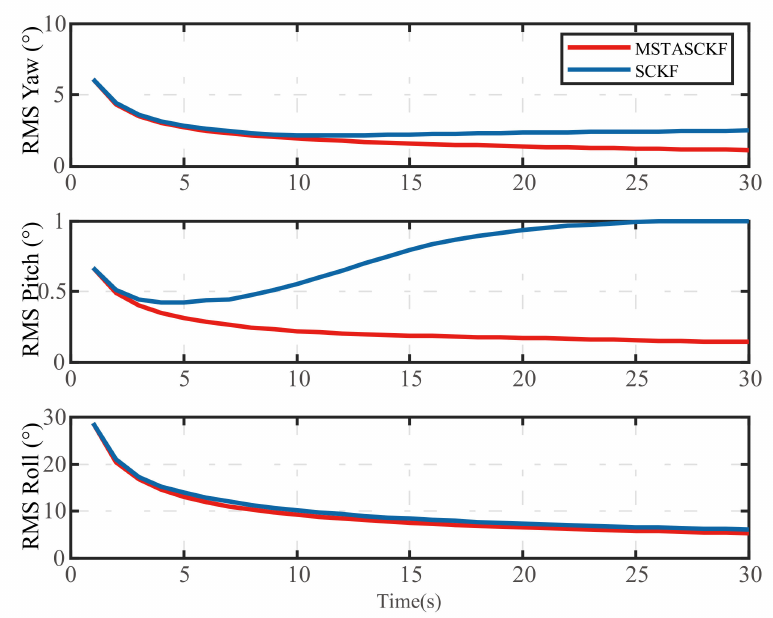
Figure 7. The RMS of the attitude error of MSTASCKF and SCKF.